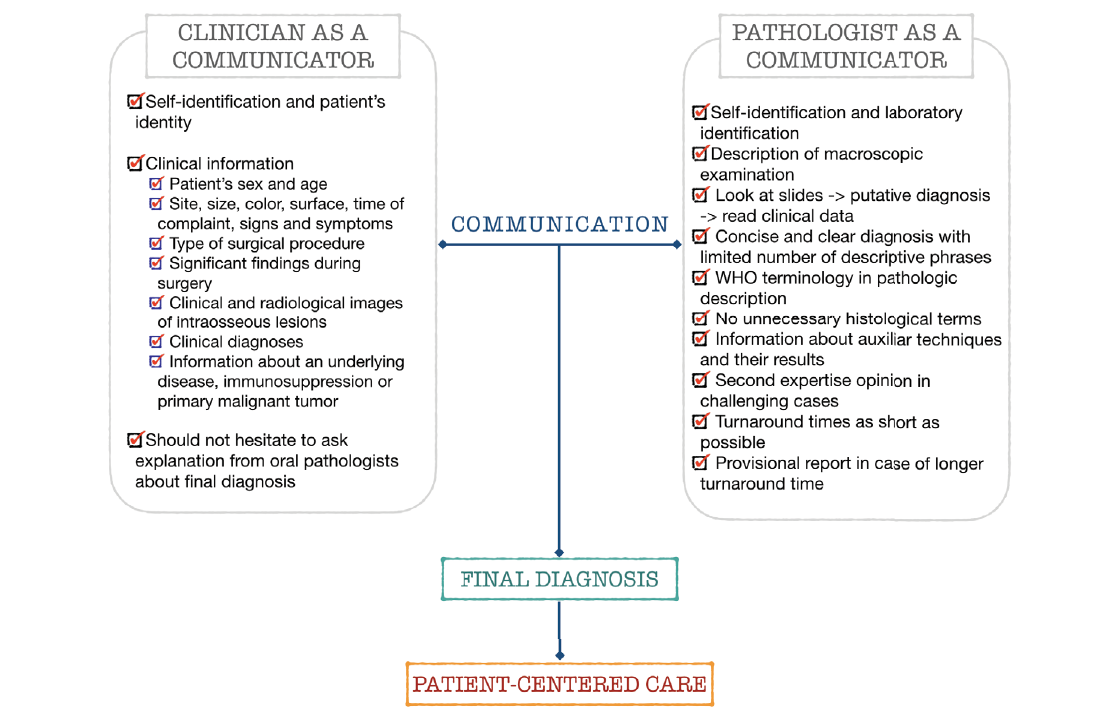
Figure 1. Schematic illustration of core clinician-pathologist communication in oral and maxillofacial pathology.